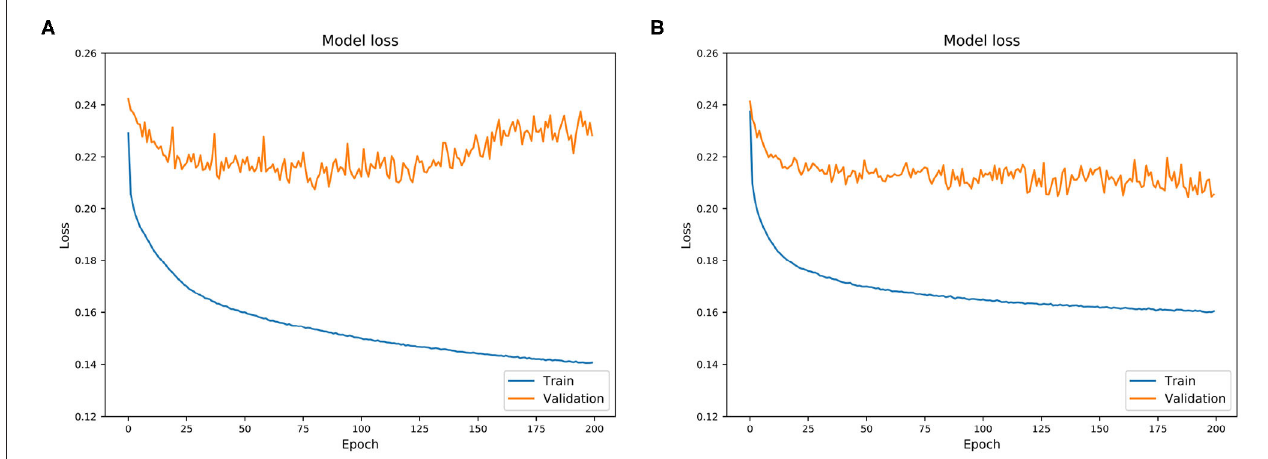
FIGURE 2 | Loss plot with overfitting. Tuning the model by optimizing the epoch number. Blue curves: model evaluation on training dataset, red curves: evaluation on validation data. After each learning iteration ( epoch ) the model loss is reduced, i.e., the model learns: (A) Loss plot with overfitting. (B) Loss plot without overfitting. Using dropout for “thinning”.